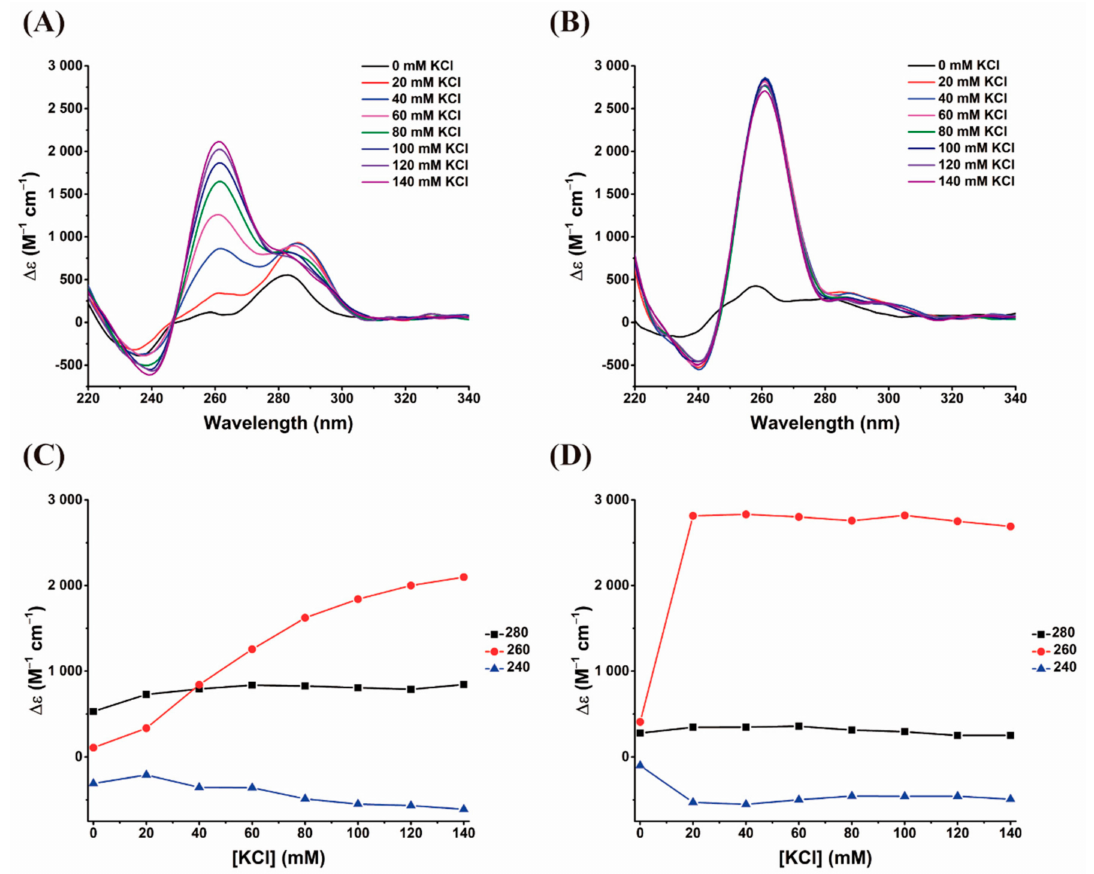
Figure 2. CD titration of 10 µ M ( A ) AS1411-N6 and ( B ) AS1411 solutions containing K + (20–140 mM range). ( C ) AS1411-N6 and ( D ) AS1411 correspond to the plots of the potassium-dependent evolution of the three characteristic bands (240, 260, 280